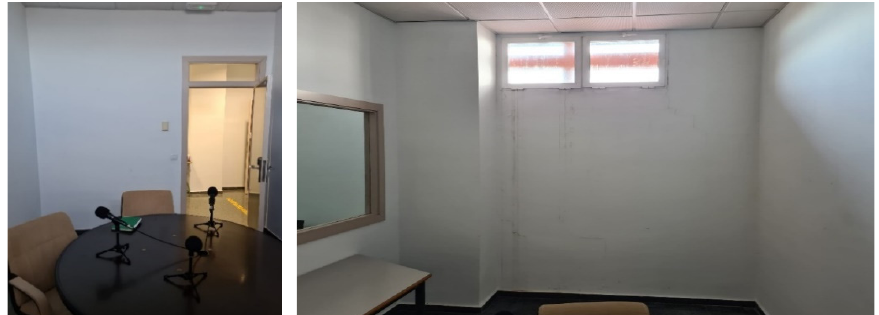
Figure 11. The initial state of the studio room.